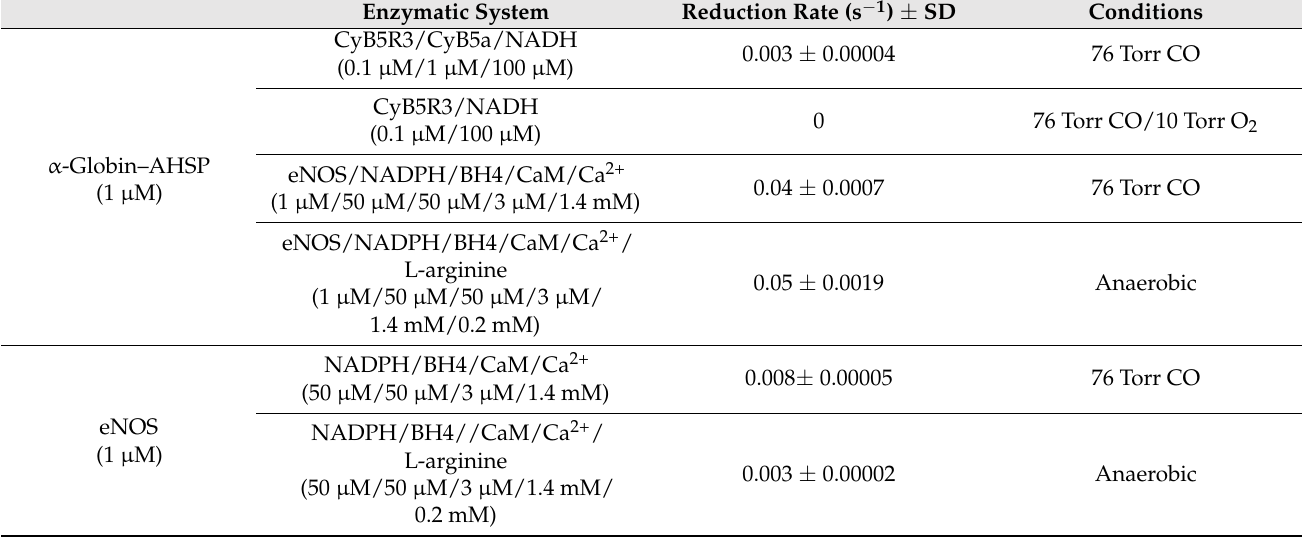
Table 1. Reduction rates for α -globin–AHSP and